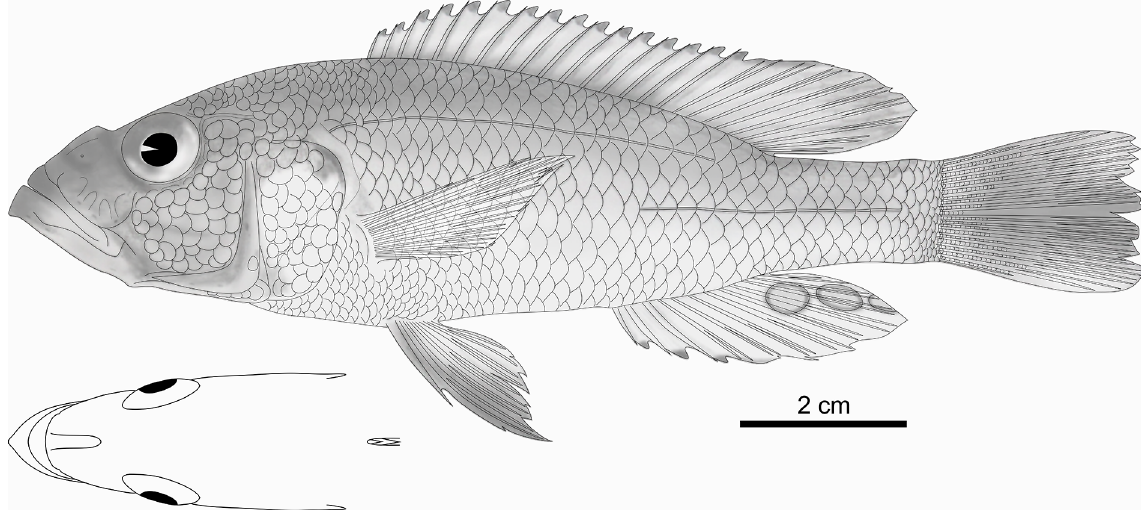
Fig. 14. Haplochromis simba sp. nov., holotype, ♂, 105.8 mm SL (RMCA 2016.035.P.0225). Drawn by N.